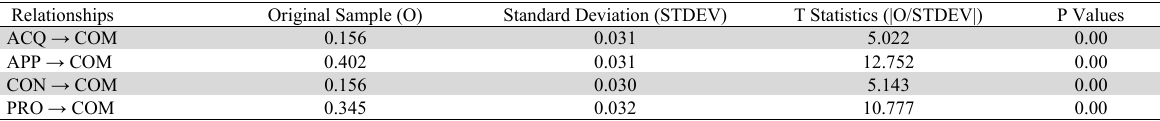
The PLS-SEM result